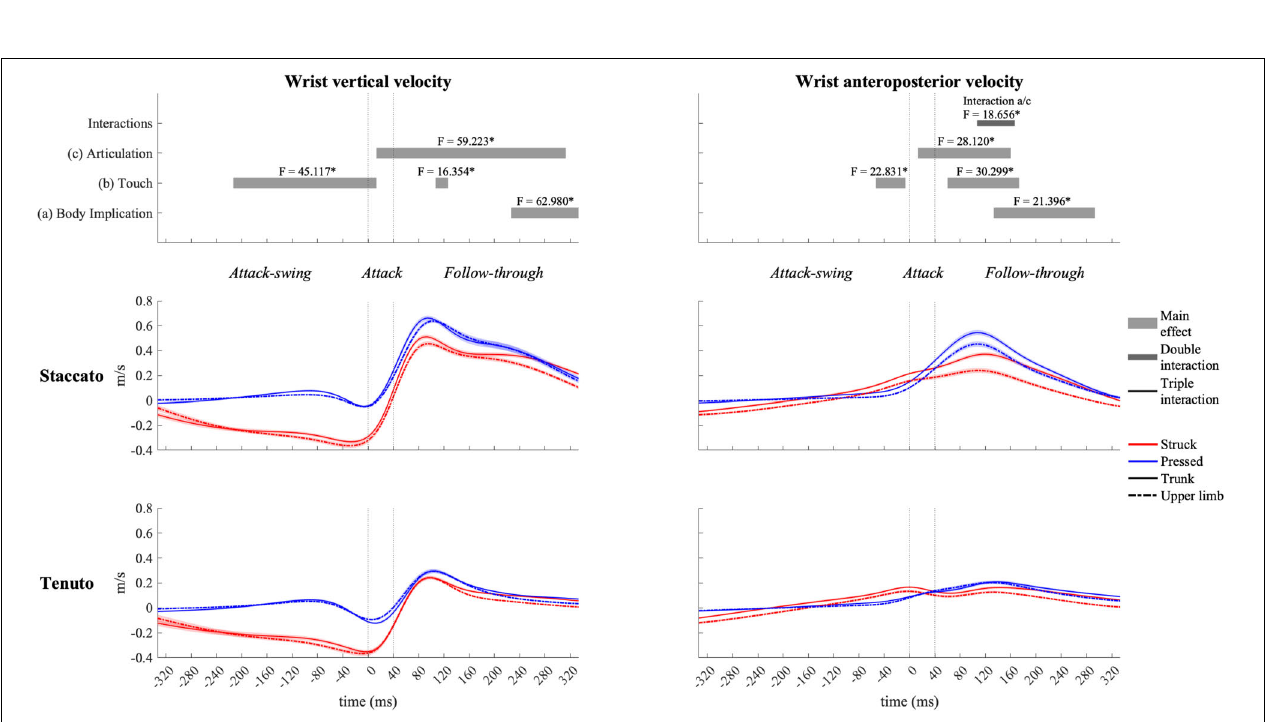
FIGURE 5 | Mean values (solid and dash-dotted lines) and 95% bootstrap confidence interval (shaded areas) of wrist linear velocities during the three phases of the keystroke. Negative/positive values indicate downward/upward velocities and backward/forward velocities. Top panels represent the results from the statistical parametric mapping of time-series values. * p -value ≤